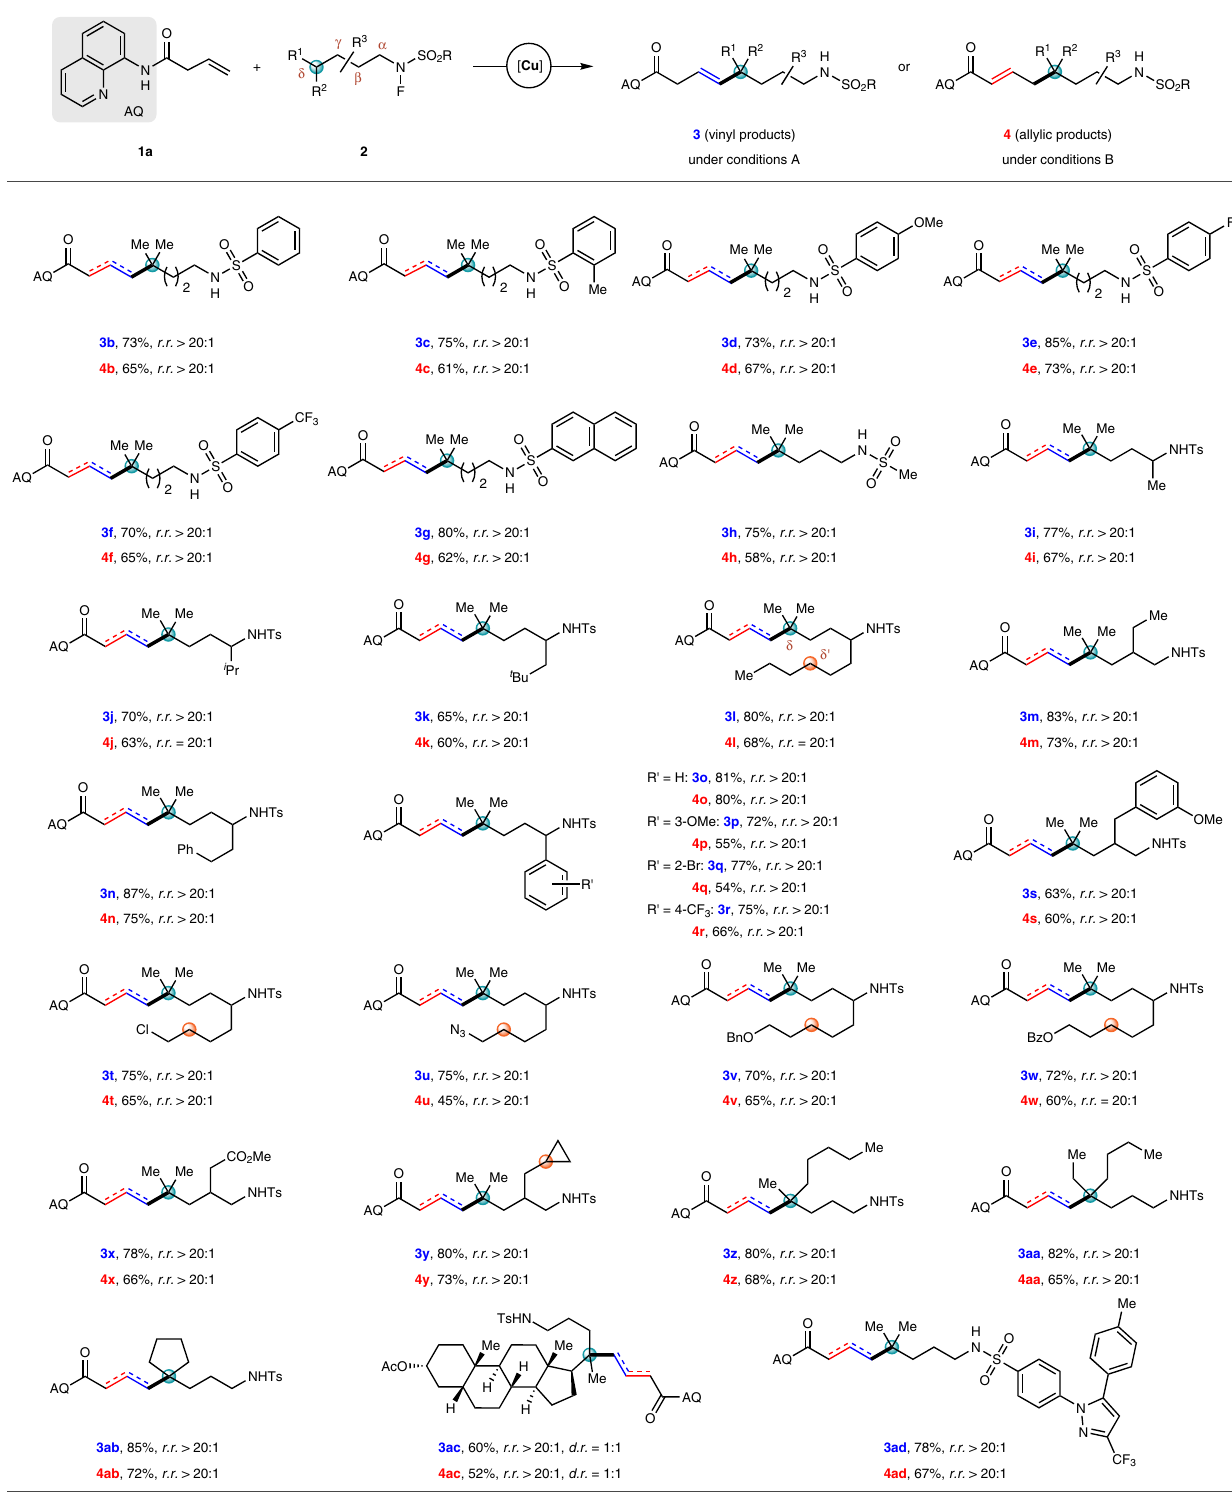
Fig. 3 | Substrates scope of N - fl uoro-amides bearing tertiary δ -C – H bonds. Conditions A (for vinyl coupling): 1a (0.20mmol), 2 (0.50mmol), and Cu(OA- c) 2 ·H 2 O (0.02mmol) in a mixed i BuOH/CH 3 CN (2.5/0.5mL) at 90°C for 3h. Con- ditions B (for allylic coupling): 1a (0.20mmol), 2 (0.50mmol), Cu(TFA) 2 ·H 2 O